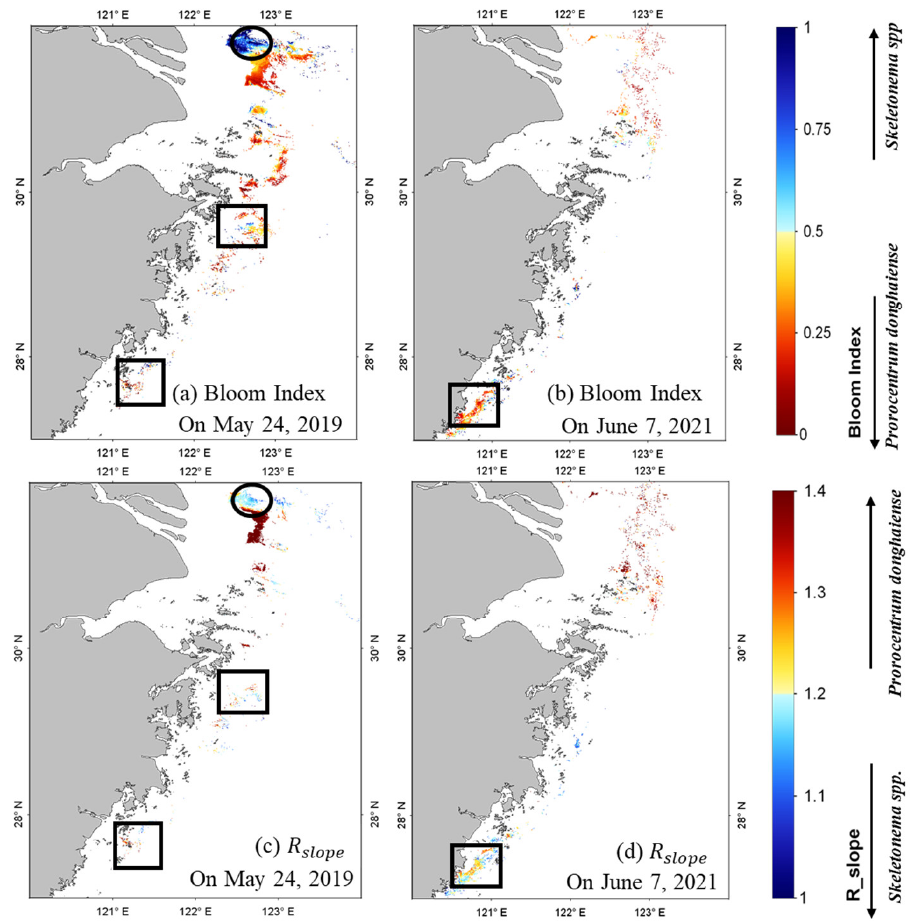
Figure 9. SGLI-derived ( a , b ) bloom index (BI) map based on the bloom detection results in Figure 8a,b, respectively; and ( c , d ) R slope map based on the bloom detection results in Figure 8a,b, respectively. The black circles and rectangles represent the location of diatom and Prorocentrum donghaiense blooms, respectively.